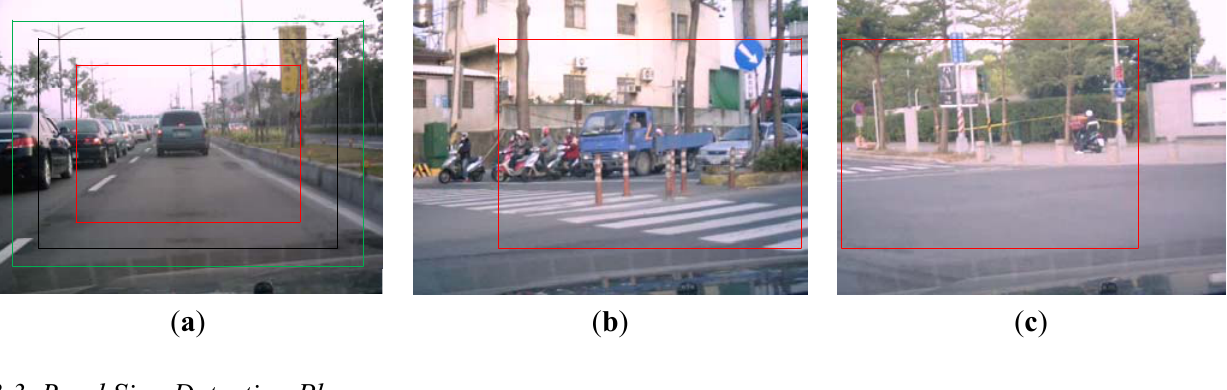
Figure 7. ( a ) Adaptive DA with different speeds: the middle rectangle for normal speed, the inner one for high speed, and the outer one for slow speed; ( b ) adaptive DA examples: turning right; ( c ) adaptive DA examples: turning